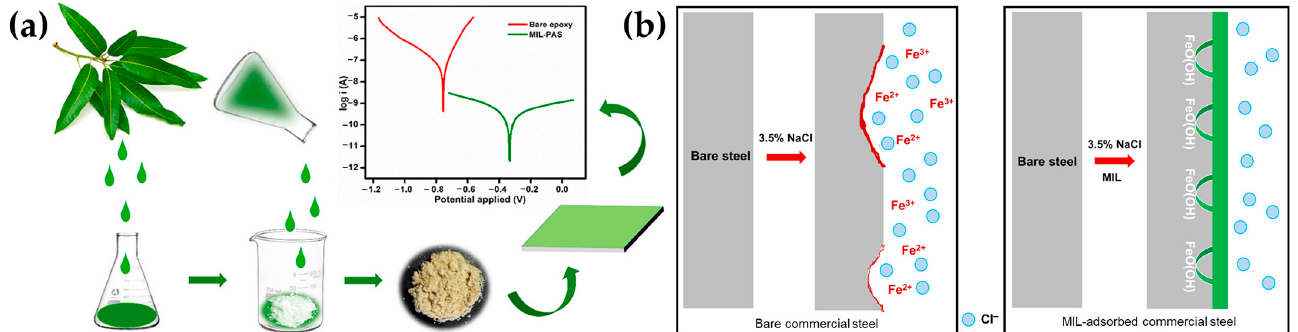
Figure 6. Preparation of the hybrid epoxy coating containing precipitated amorphous silica func- tionalized with MIL extract with its anticorrosive behavior ( a ) and mechanism of corrosion inhibi- tion of bare commercial steel and MIL-adsorbed commercial steel in a saline environment ( b ). Adapted from Ref. [60]. Copyright 2019, K. K. Veedu, ACS Omega, American Chemical Society.